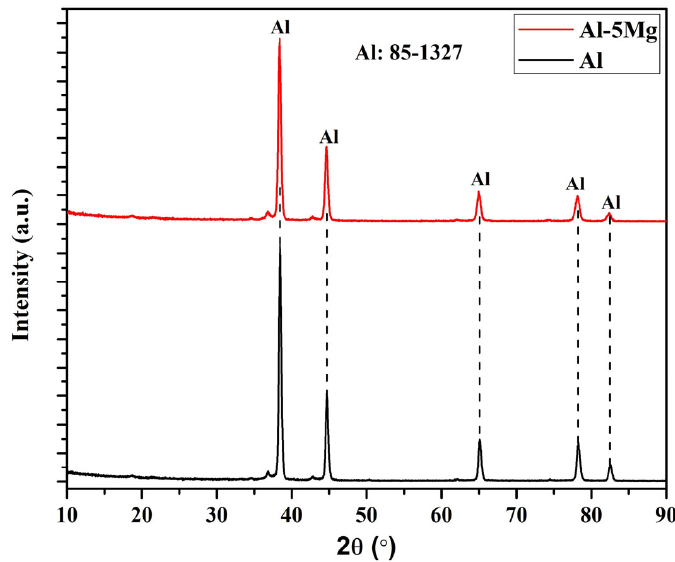
Figure 4. XRD of the coatings.